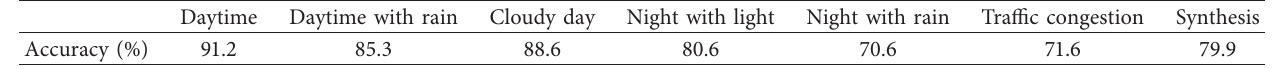
Table 1: Statistics of algorithm accuracy in different environments.